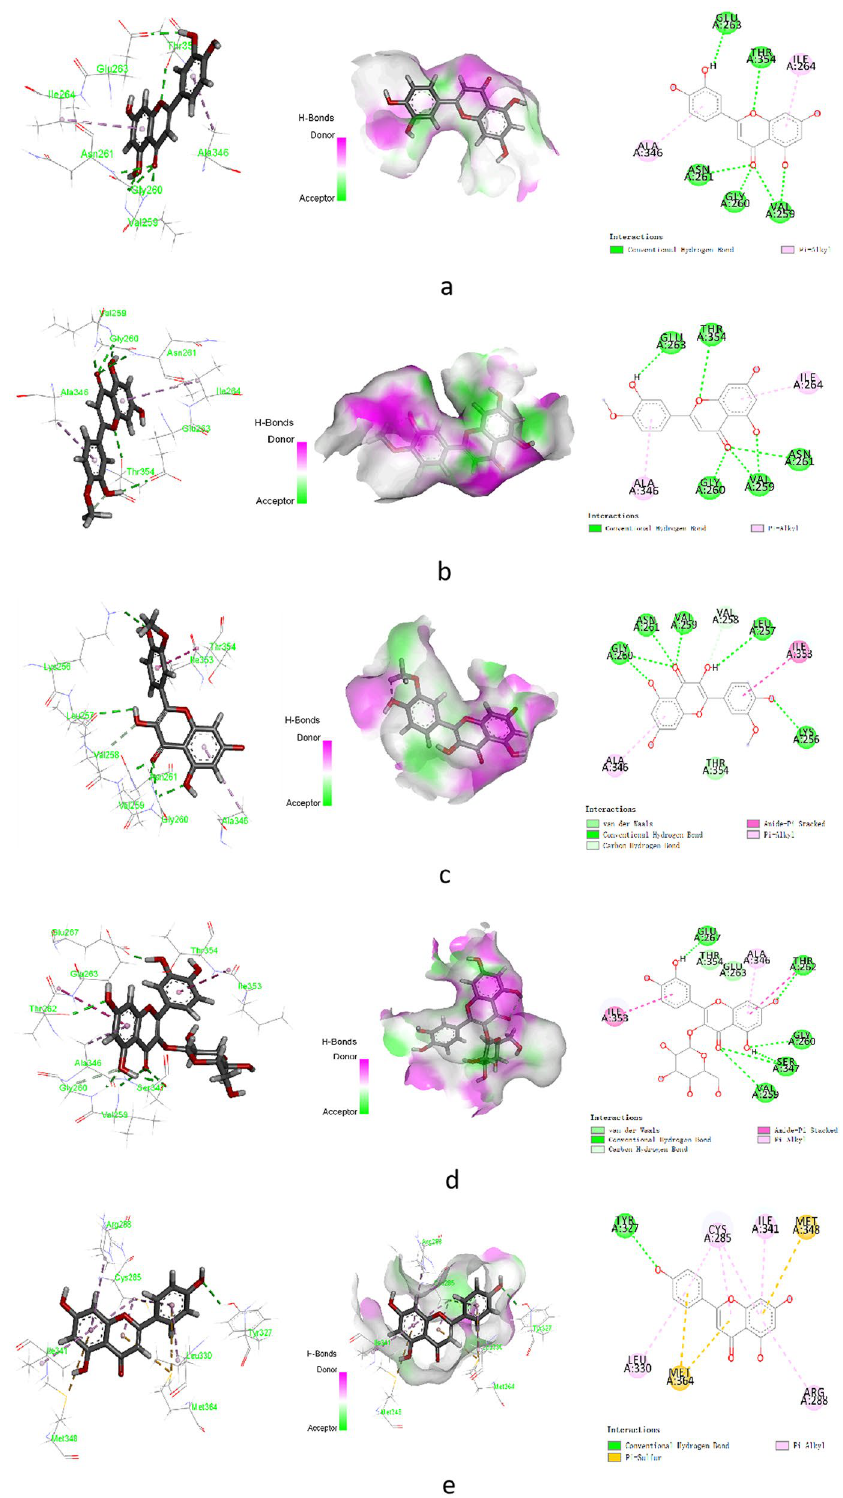
Figure 3. The molecular docking results between the compounds ( a ) luteolin, ( b ) diosmetin, ( c ) isorhamnetin, and ( d ) hyperin and the protein XDH. ( e ) The molecular docking results between the compounds apigenin and the protein